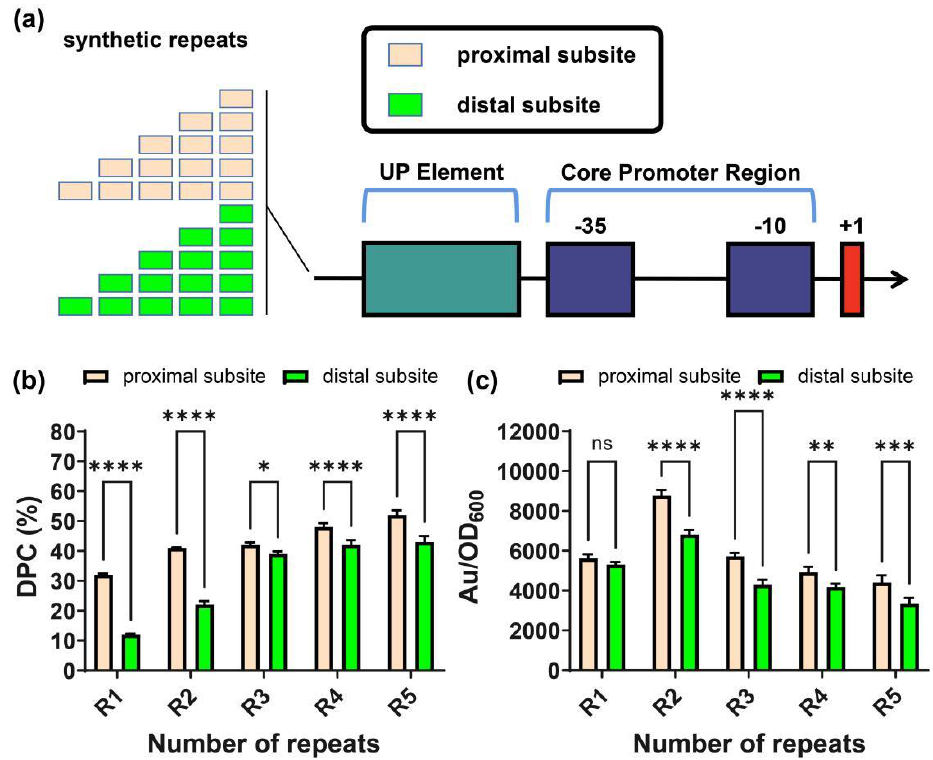
Figure 6. Illustration of the synthetic promoters and the characterization of their DPC and expression strength. ( a ) Different repeats of proximal/distal subsites were inserted upstream of the core promoter region of P trxA -UP5. ( b ) The DPC was investigated between synthetic promoters harboring different repeats of proximal/distal subsites. ( c ) The expression strength of the synthetic promoters was detected by the fluorescent method. Au—Arbitrary unit. Results are expressed as mean of replicates; columns with ****, ***, ** or * represent statistically significant differences between groups at p < 0.0001, p < 0.001, p < 0.01 or p < 0.05, respectively.